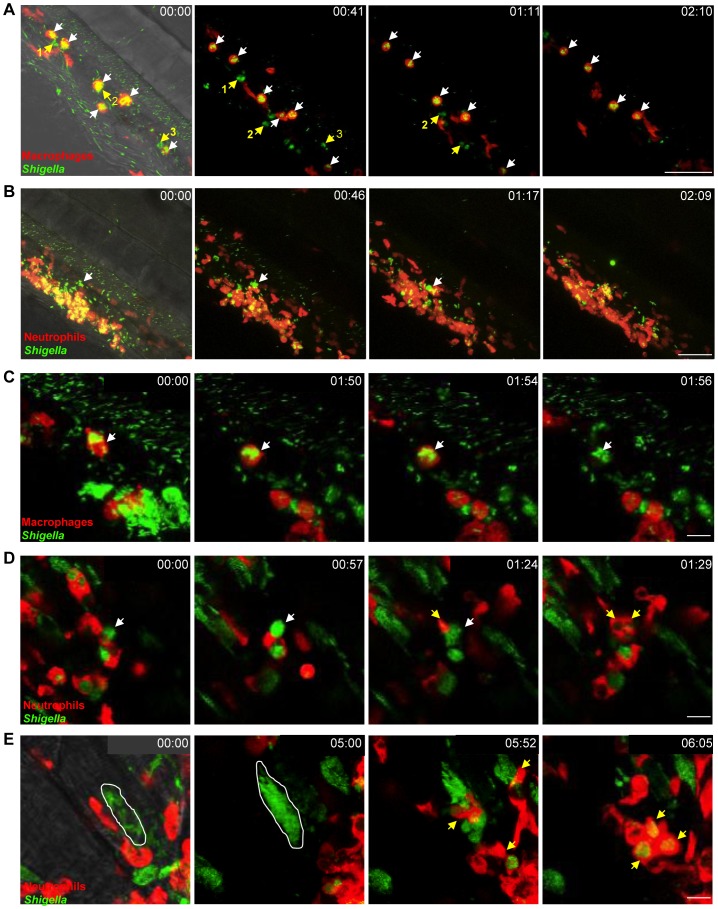

In vivo Shigella-phagocyte interactions.A–E: Frames extracted from in vivo time-lapse confocal imaging sessions of 3 dpf larvae injected in the bloodstream and in the adjacent mesenchyme with sublethal inocula of GFP-Shigella. Caudal area, rostral to bottom right, dorsal to top right. Overlay of green (Shigella) and red (macrophages or neutrophils) fluorescence; transmission image (grey) is also overlaid on the first frame in A, B and E as an anatomical guide. Scale bars: A–B, 50 µm; C–E, 10 µm. A. mpeg1:G/U:mCherry larva (red macrophages); first frame at 20 mpi. By 20 mpi, Shigella have already adhered to or have been engulfed by macrophages (red cells, white arrows). They persist in macrophages over time (last frame at 2h30pi). Note that neutrophils (highlighted in green by the engulfed GFP-Shigella, #1,2,3 yellow arrows), that have engulfed bacteria in the mesenchyme have a similar bacterial load to that of macrophages, and efficiently kill the engulfed bacteria (as indicated by the diffuse GFP staining over time in these neutrophils). Maximum intensity projection from 25 planes every 2 µm. See also Video S1. B. lyz:dsRed larva (red neutrophils), first frame at 20 mpi. Neutrophils are rapidly recruited to engulf and degrade GFP-Shigella in the mesenchyme. By contrast, note the macrophage that remains strongly decorated by GFP-Shigella over time (white arrow), highlighting bacterial persistence inside macrophages. Maximum intensity projection from 25 planes every 2 µm. See also Video S4. C. mpeg1:G/U:mCherry larva, first frame at 20 mpi. A red macrophage harboring GFP-Shigella over time (white arrow) eventually undergoes cell death (loss of red label). Note in the bottom right corner of the field a group of neutrophils that have engulfed the bacteria in the mesenchyme and appear engorged by them, is able to control the engulfed GFP-Shigella over time (diffuse and decreasing in intensity GFP signal). Maximum intensity projection of 6 planes every 2 µm. See also Video S5. D. lyz:dsRed larva, first frame at 4h30pi. Neutrophils collect dying infected macrophages. GFP-Shigella proliferate inside a macrophage (white arrow), which then undergoes cell death, and is quickly engulfed by dsRed+ neutrophils (yellow arrows). Single confocal plane. See also Video S6. E. lyz:dsRed larva, first frame at 7 hpi. Shigella are able to invade other cell types and replicate in the cytoplasm, causing their death, and subsequent engulfment by neutrophils. The white line delineates a muscle fiber invaded by GFP-Shigella. Shortly before 6 h of time-lapse, the muscle cell bursts and is engulfed by red neutrophils (yellow arrows). Maximum intensity projection of 4 planes every 2 µm. See also Video S7.